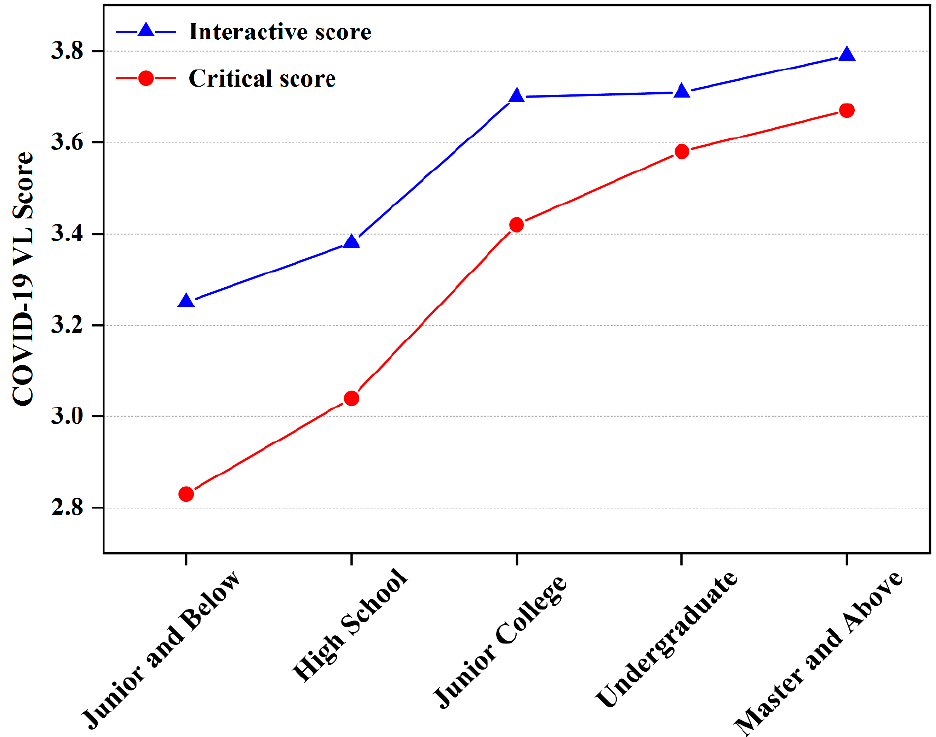
Figure 1. Relationship between different educational levels and vaccine literacy. Significant associations were also found between functional vaccine literacy and age, marital status, and occupation, with the highest scores among those aged 55 years or older